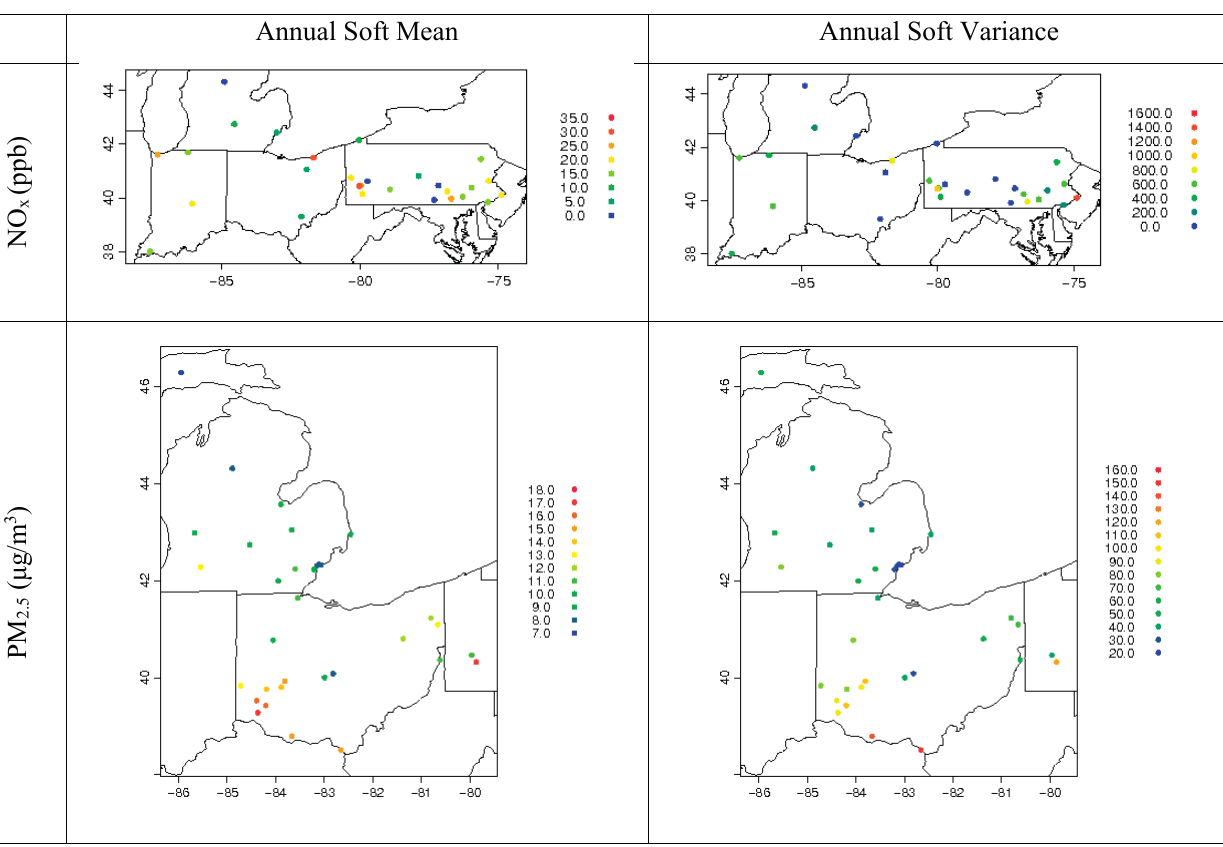
Figure 7. Annual soft mean and variance for NO x and PM 2.5 at all available monitors used for STOK